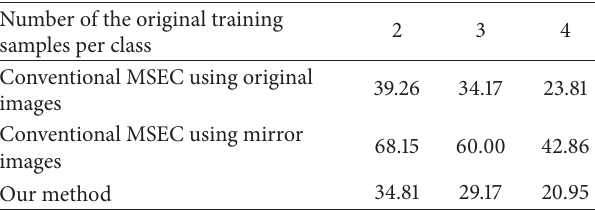
Table 3: Rate of classification errors (%) on the Yale